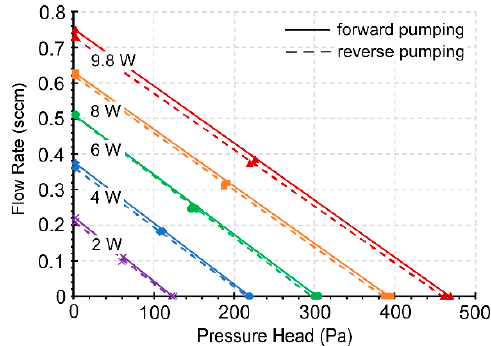
Figure 9. Steady-state performance of the 3D-KP.AAO showing the flow rate against the pressure head at five power levels. The AAO membranes can tolerate higher operating power than MCE membranes. The forward and reverse pumping are almost identical.